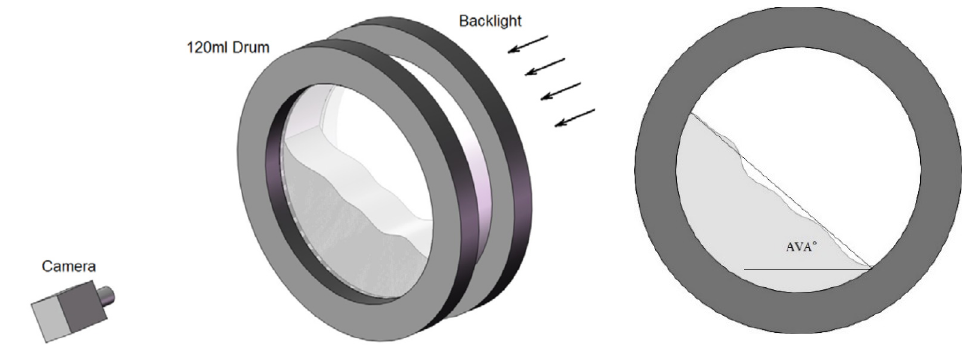
Figure 4. Schematic of AVA measurement.